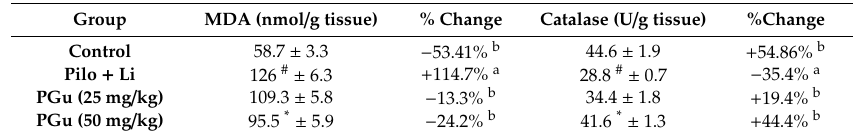
Figure 3. Effects of PGu on pilocarpine + lithium-induced seizures in rats on seizure onset ( A ), seizure duration ( B ) and seizure score ( C ). LiCl was injected i.p. in a dose of 3 mEq / kg b.w. After 24 h, the animals were injected with pilocarpine hydrochloride in a dose of 30 mg / kg b.w. PGu was given in doses 25 and 50 mg / kg twice and the second dose was given 1 h before piloarpine. Data are presented as median (25th, 75th percentile) and analyzed by Kruskal–Wallis and Dunn’s as a post-hoc test. The superscript * indicates significance in relation to the pilocarpine + lithium-treated group at p < 0.05. Table 2. Effect of PGu on the oxidative stress biomarkers (MDA) and (CAT) in pilocarpine-induced seizures in a rat model.